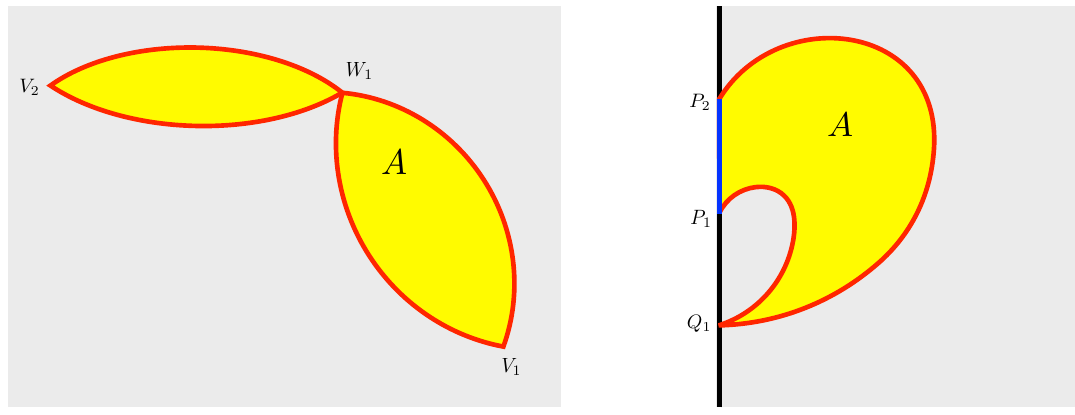
Figure 1 . Examples of (cid:12)nite two dimensional regions A (yellow domains) containing the kinds of corners considered in this manuscript. Left: A is a domain in the plane with three corners and two di(cid:11)erent kinds of vertices. Right: A is a domain in the half plane with three corners whose boundary @A intersects the boundary of the BCFT 3 (solid black line). The three vertices in @A are also on the boundary of the BCFT 3 and they belong to two di(cid:11)erent classes of vertices. In both panels, the red curve corresponds to the entangling curve @A \ @B , whose length provides the area law term in (1.2) and in